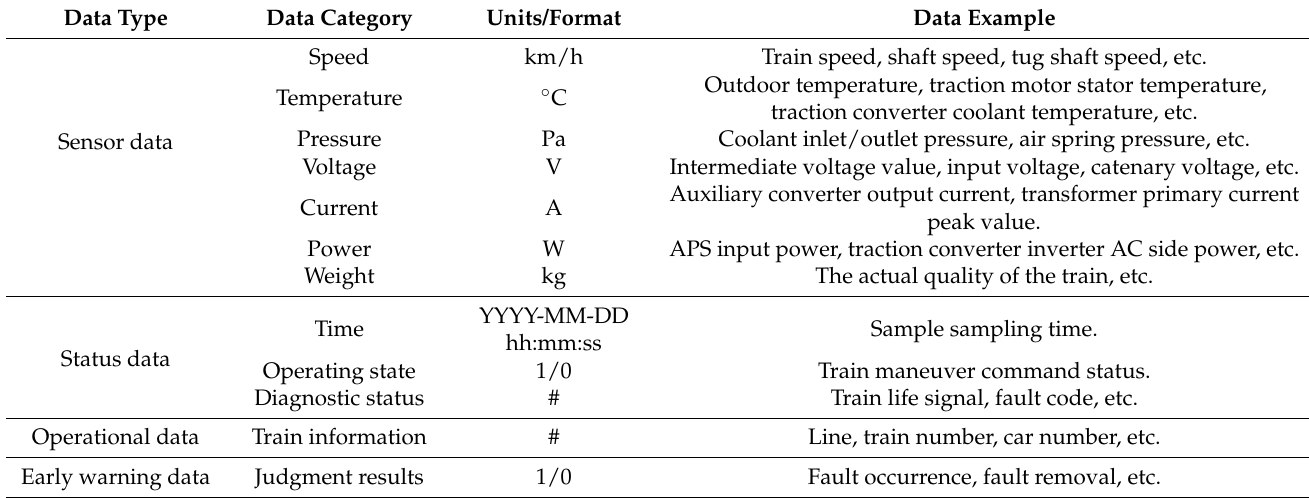
Figure 3. Schematic diagram of high-speed train sensor distribution. Table 1. Dataset type description and